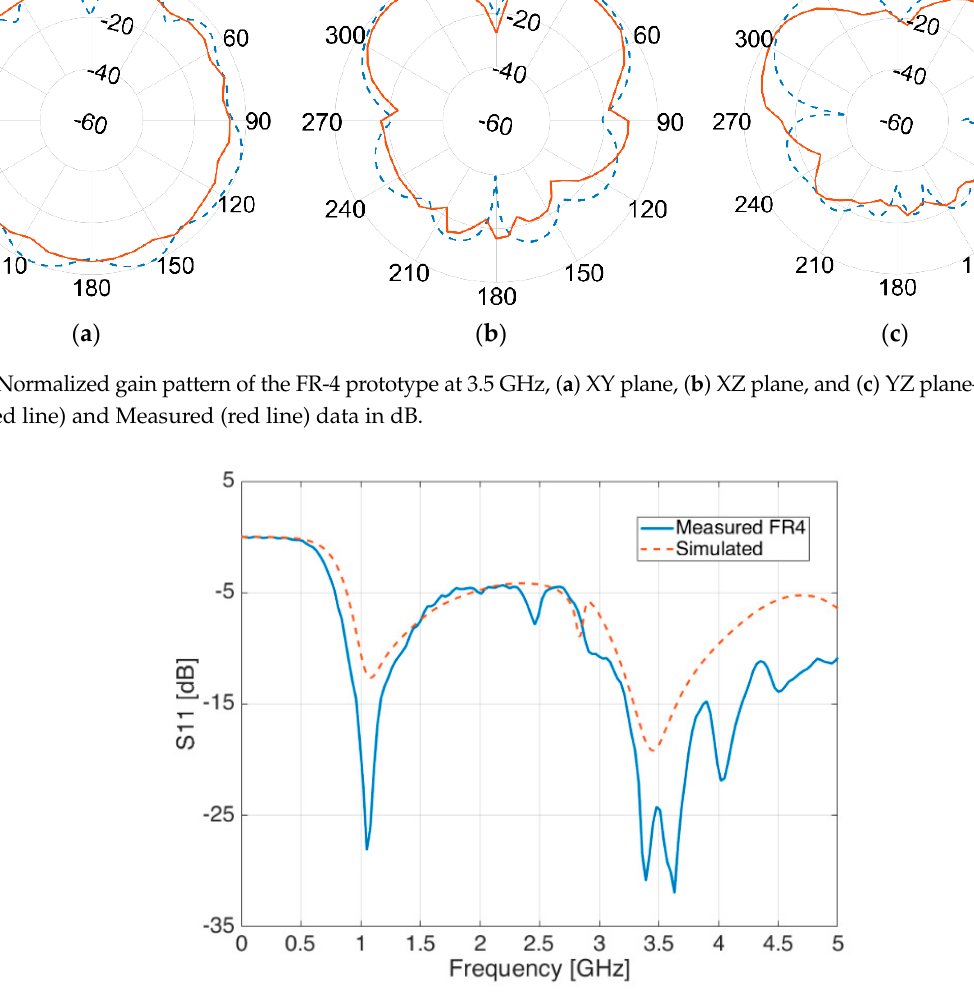
Figure 25. Reflection coefficient S 11 of simulated antennas (red dashed line) and measured (blue continuous line) in FR-4 material.